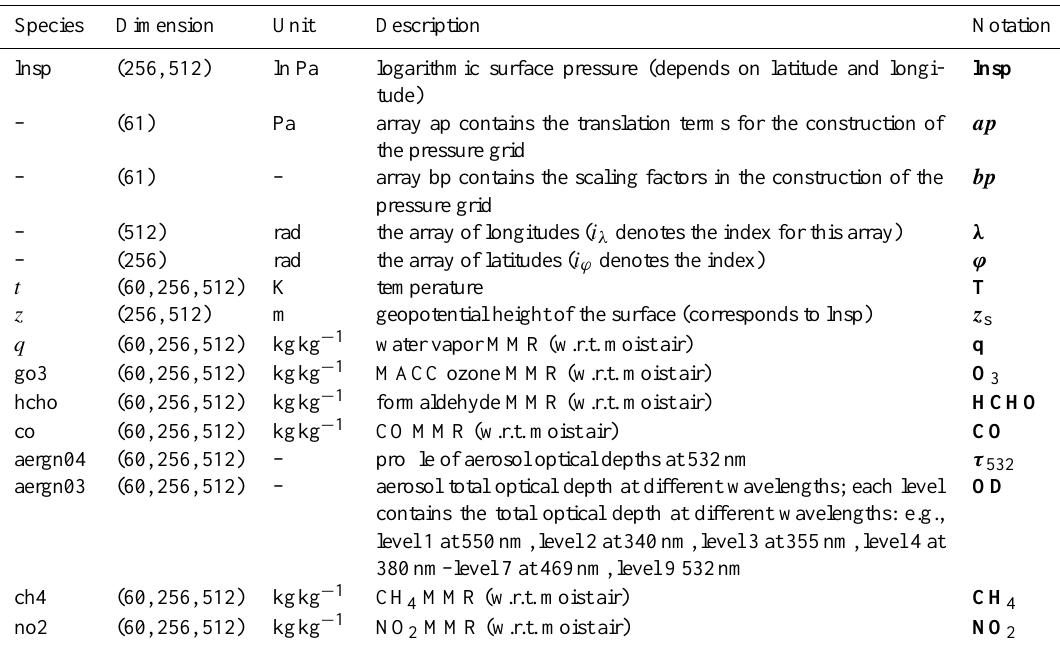
Table 3. MACC variables specifications. MMR is mass mixing ratio. The dimensions are indicative for a model with IFS resolution